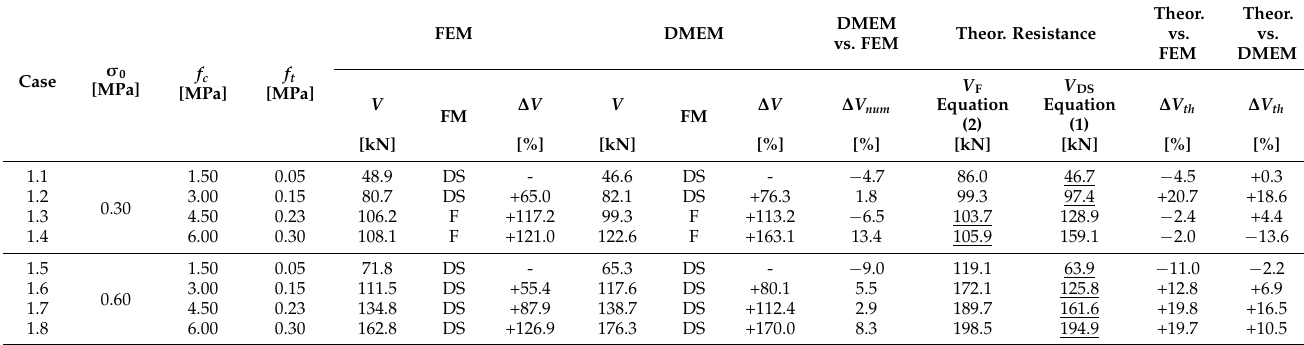
Table 7. Shear resistances of Group